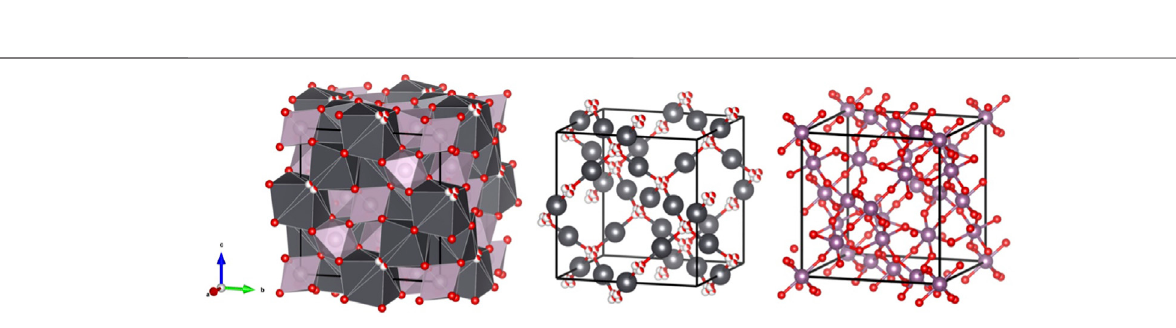
Frontiers in Chemistry |